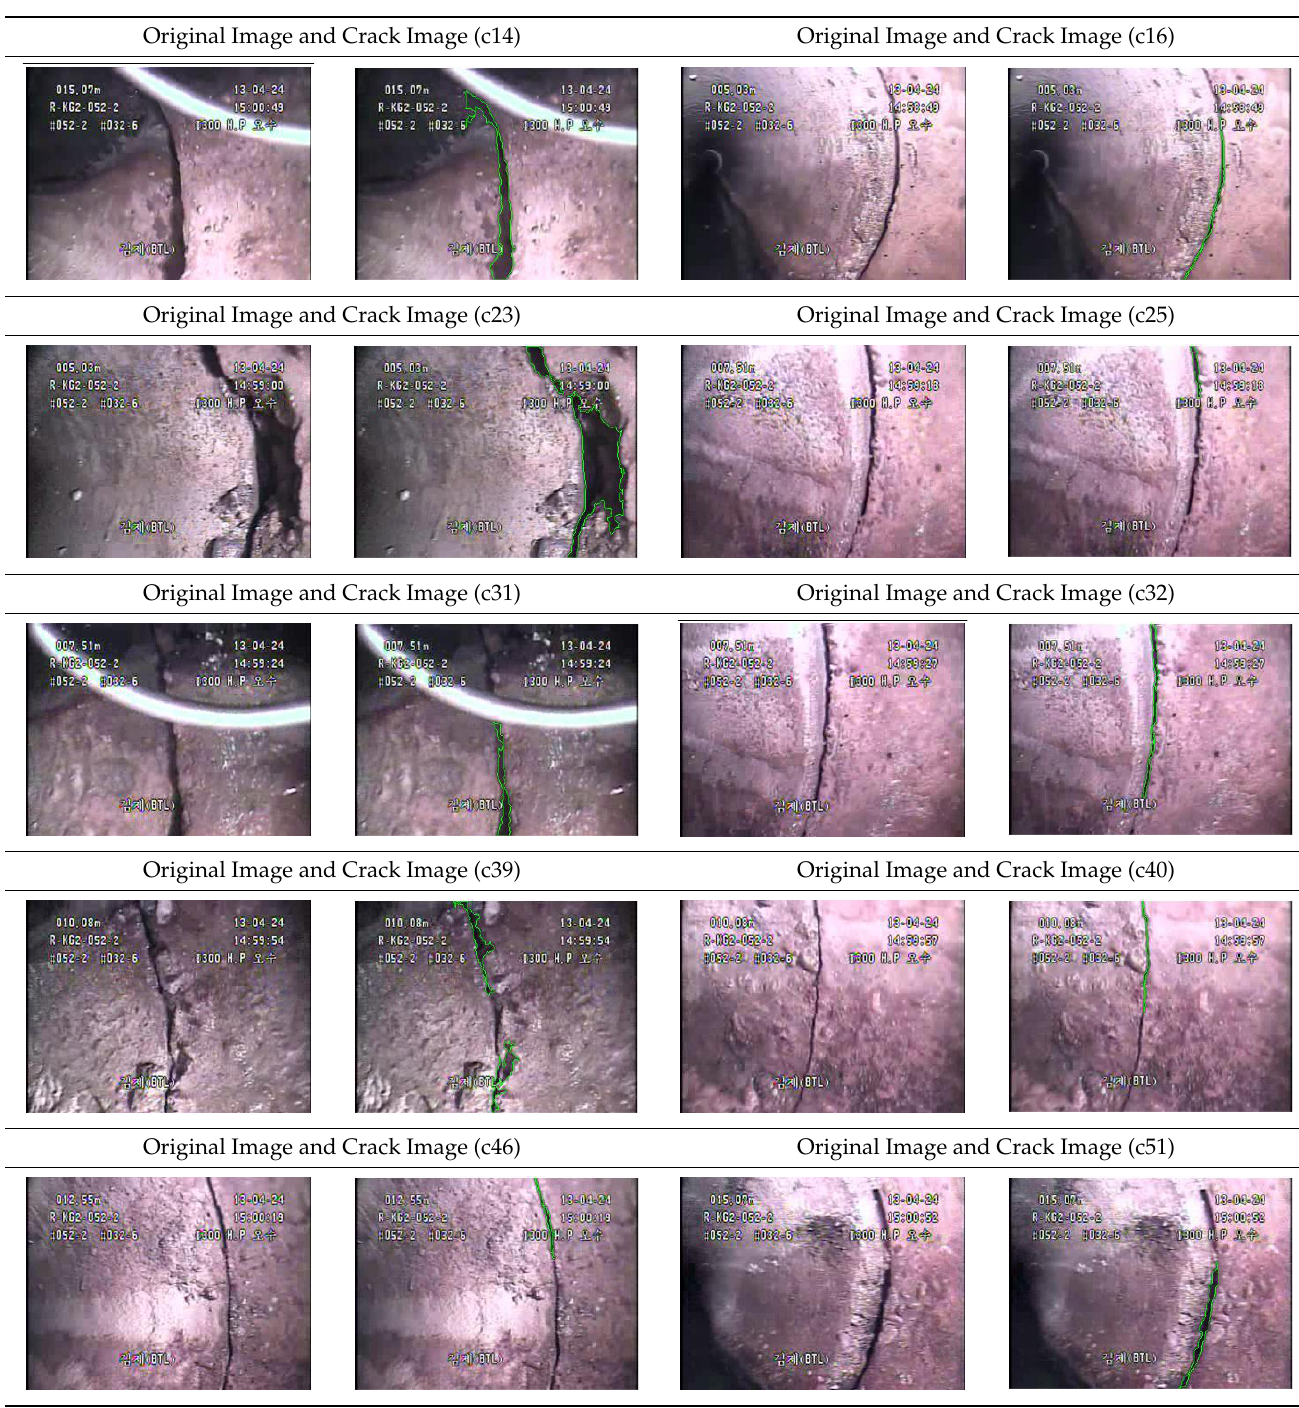
Table 14. Bad results of crack and non-crack images (all results).